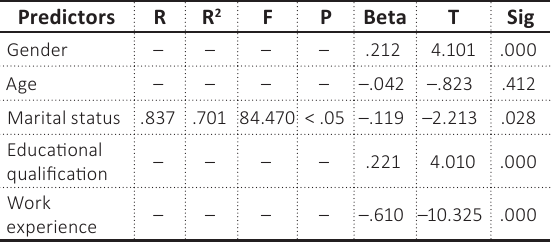
Table 2 reveals that self-efficacy and social